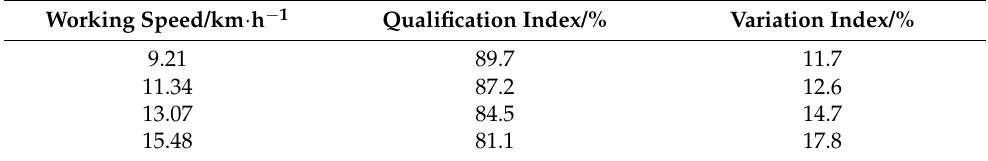
Table 5. Field test